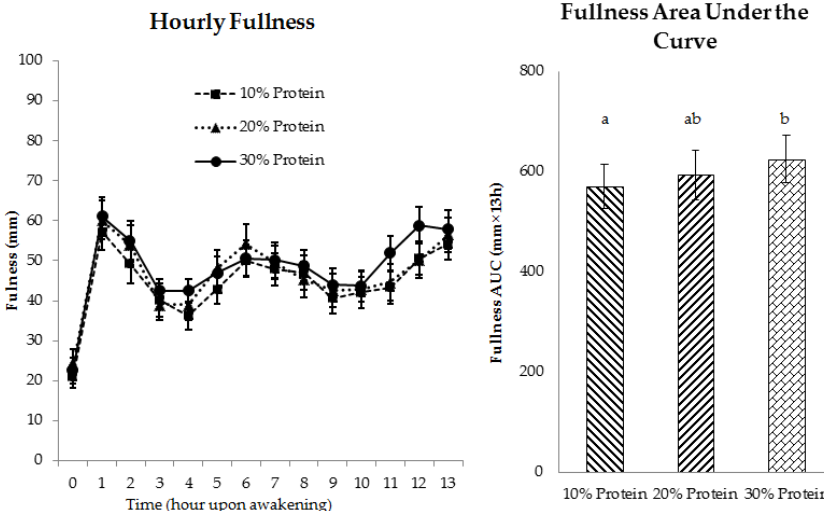
Figure 4. Daily fullness rating at the end of each 4-week period (days 25–27) independent of protein source. a,b : Values with different letters differ significantly, p = 0.03.